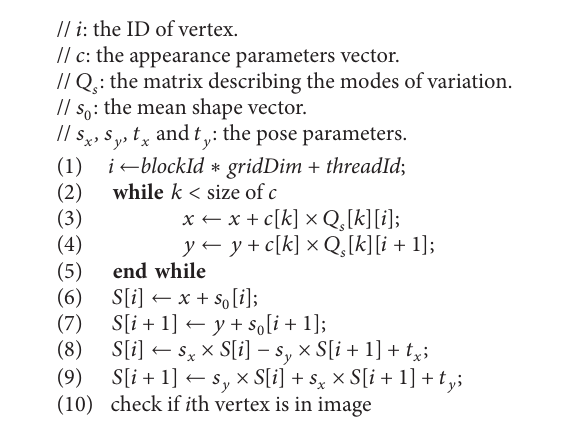
Algorithm 3: GPU-based method for calculating S